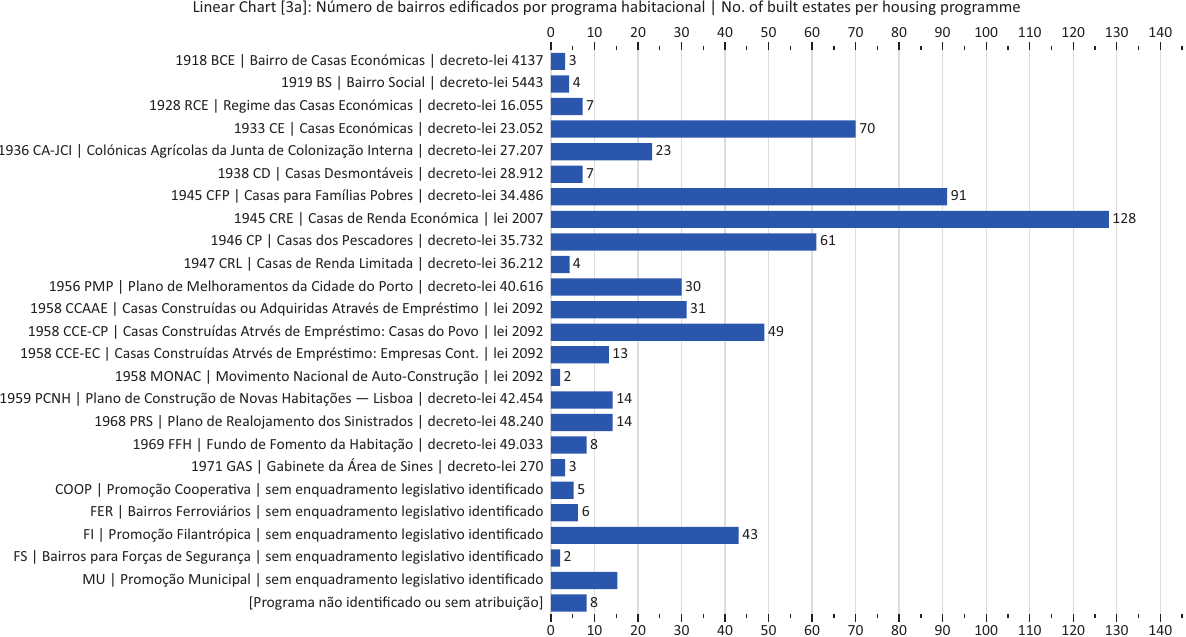
CCAAE | Casas Construídas ou Adquiridas Através de Emprés mo | lei 2092 1958 CCE-CP | Casas Construídas Atrvés de Emprés mo: Casas do Povo | lei 2092 1958 CCE-EC | Casas Construídas Atrvés de Emprés mo: Empresas Cont. | lei 2092 1958 MONAC | Movimento Nacional de Auto-Construção | lei 1959 PCNH | Plano de Construção de Novas Habitações — Lisboa | decreto-lei 42.454 1968 PRS | Plano de Realojamento dos Sinistrados | decreto-lei 48.240 1969 FFH | Fundo de Fomento da Habitação | decreto-lei 49.033 1971 GAS | Gabinete da Área de Sines | decreto-lei 270 COOP | Promoção Coopera va | sem enquadramento legisla vo iden ficado FER | Bairros Ferroviários | sem enquadramento legisla vo iden ficado FI | Promoção Filantrópica | sem enquadramento legisla vo iden ficado FS | Bairros para Forças de Segurança | sem enquadramento legisla vo iden ficado MU | Promoção Municipal | sem enquadramento legisla vo iden ficado [Programa não iden ficado ou sem